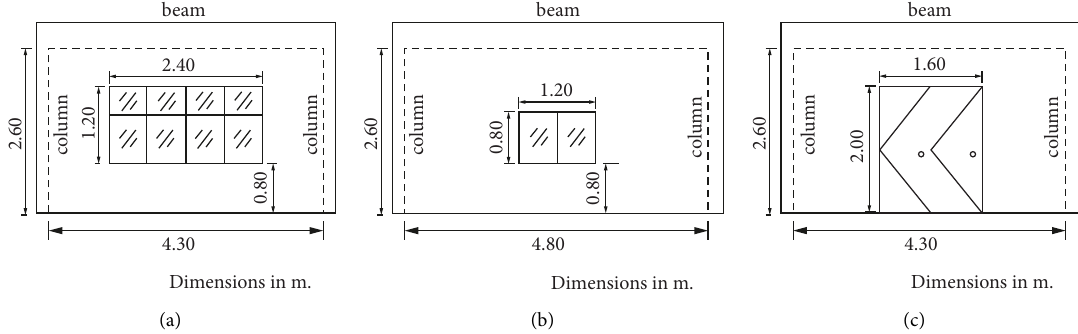
Figure 4: Confgurations and dimensions of the masonry-inflled walls. (a) WallA. (b) WallB. (c) WallC.